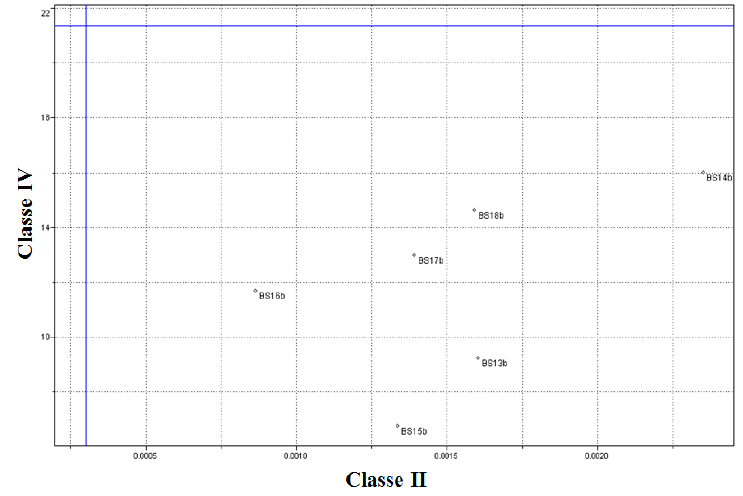
Figure 9. SIMCA Model—Distance between the classes for testing biodiesel samples (Class II versus Class